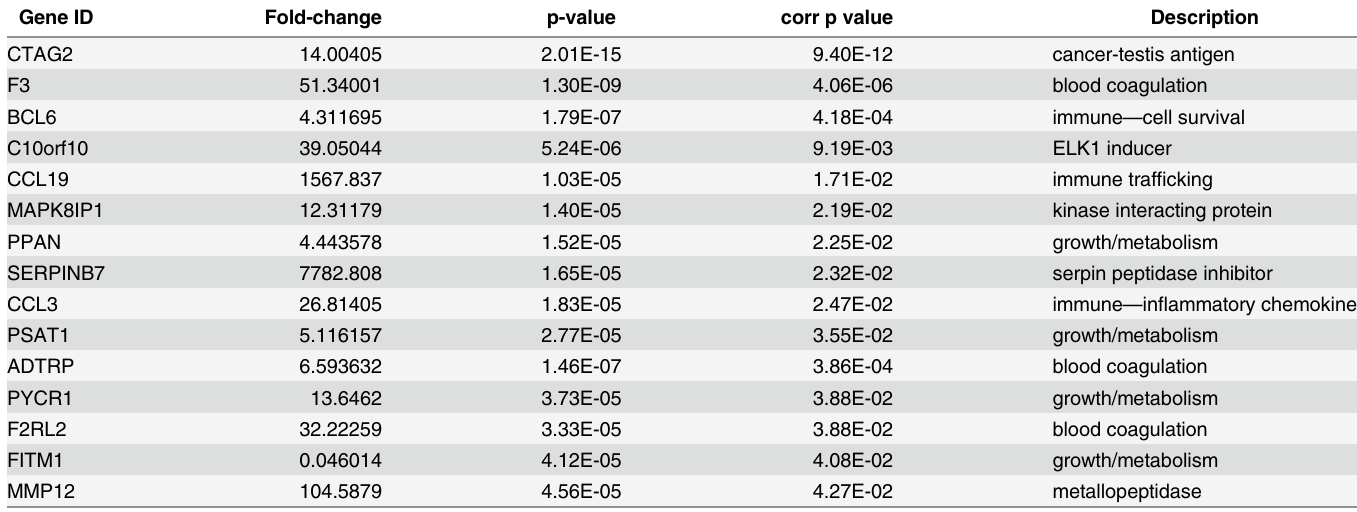
Table 3. Differentially regulated transcripts among subjects with asymptomatic versus neuroinvasive WNV infection. Gene